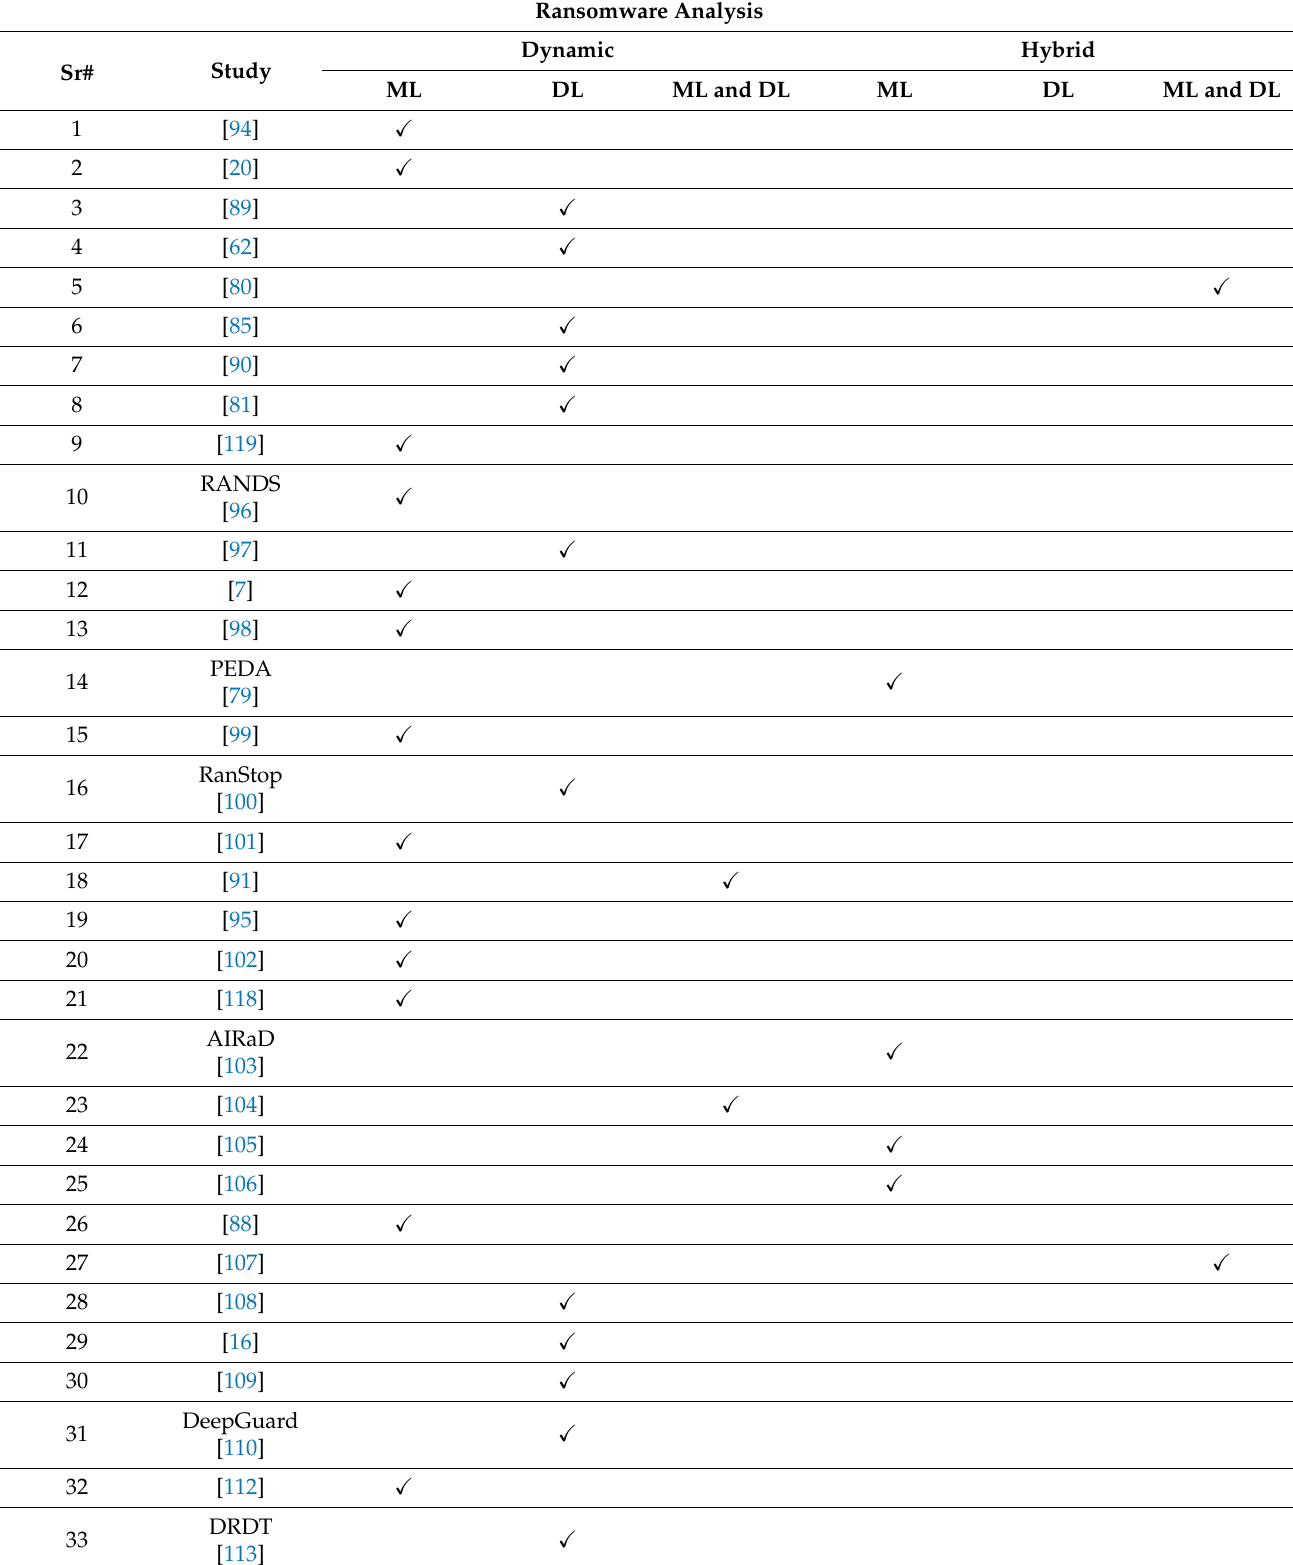
Table 4. Studies performed dynamic and hybrid analysis for ransomware